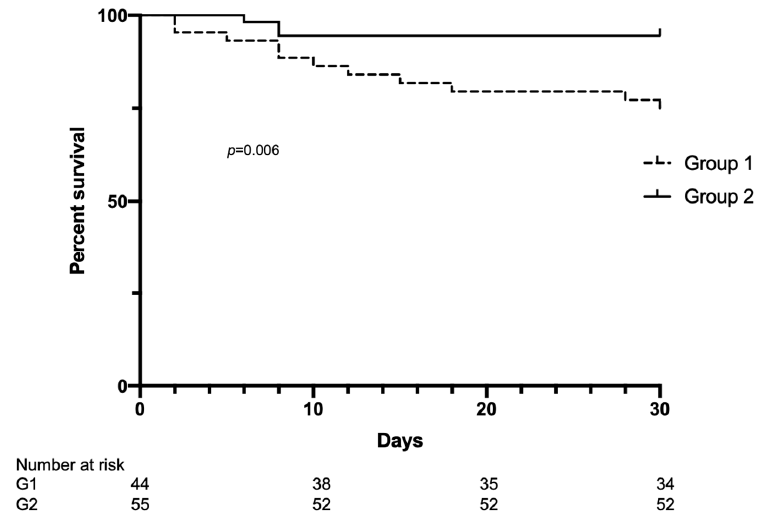
Figure 2. Kaplan–Meier curves of 30-day survival in hemodialysis patients affected by COVID-19 during the first pandemic waves and the last wave of 2021. Group 1, from March to December 2020; Group 2, from September 2021 to February 2022.